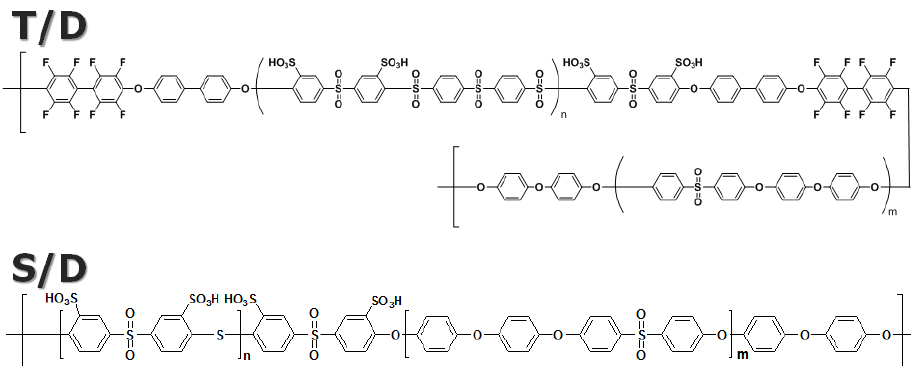
Figure 1. Chemical structures of sulfonated polyarylene sulfone-multiblock copolymers used as PEM models in the mesoscale simulation of this study. Table 1. Characteristics of sulfonated polyarylene sulfone-multiblock copolymers used as PEM models in the mesoscale simulation of this study.